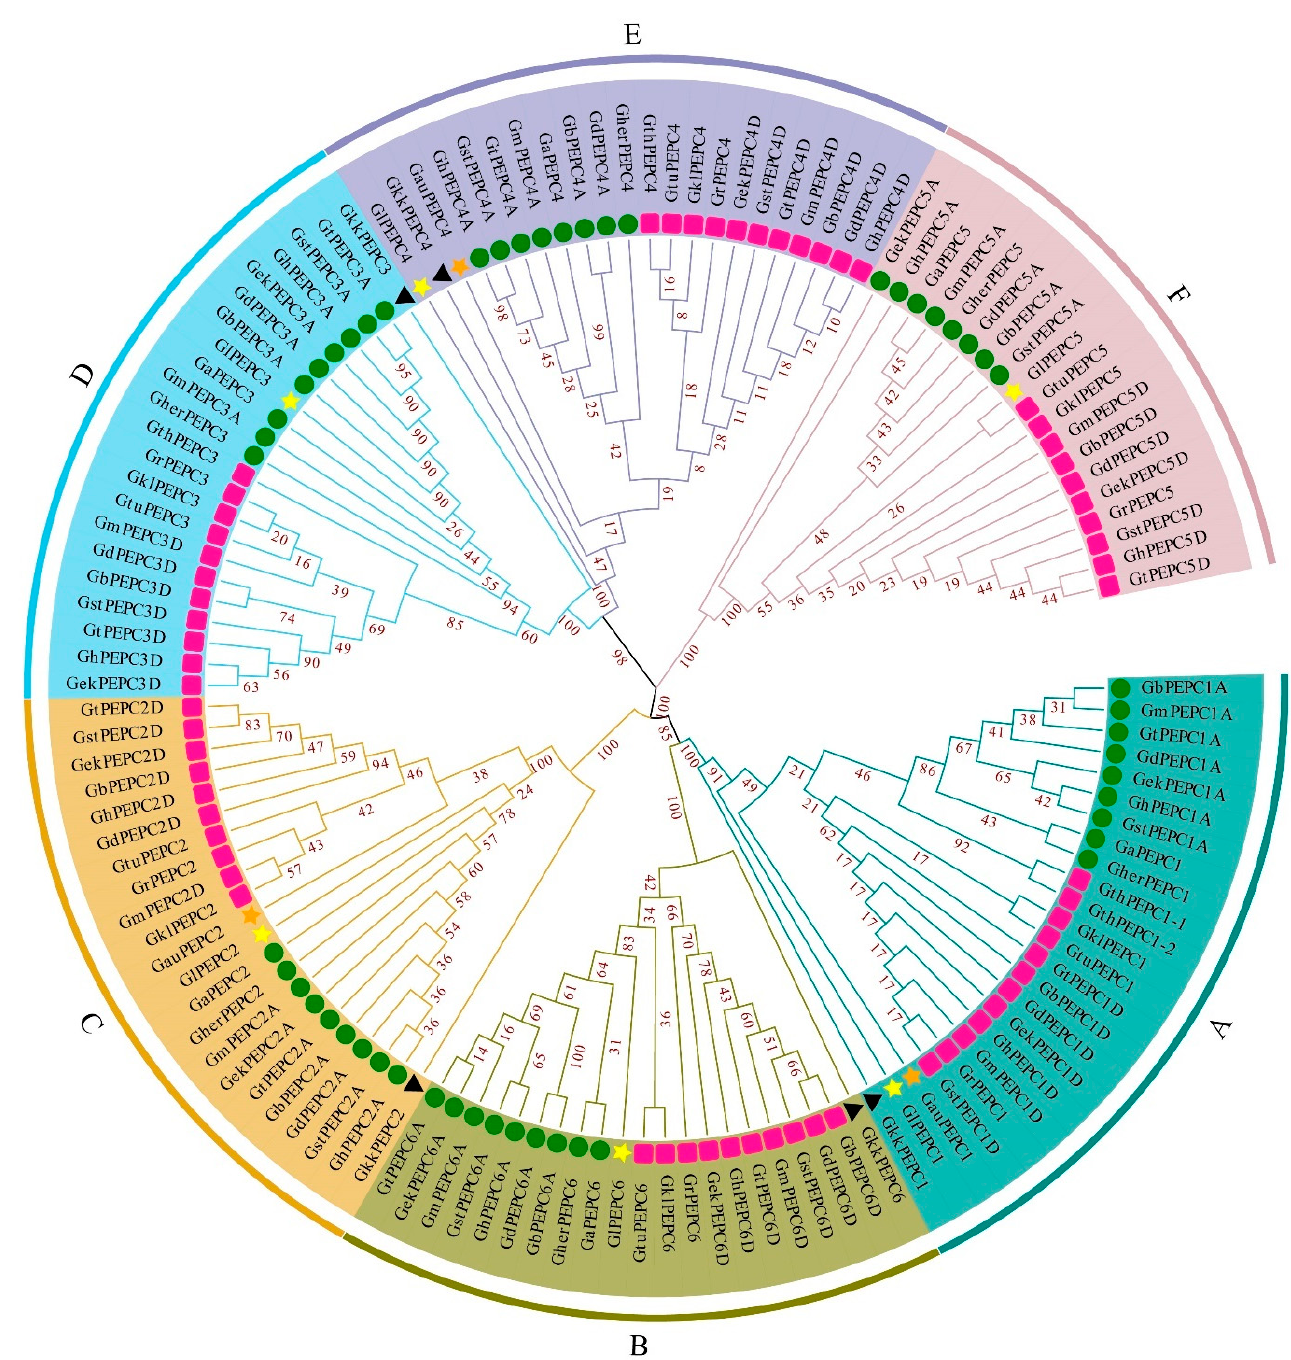
Figure 1. Phylogenetic tree of PEPC proteins from 15 Gossypium species and Gossypioides kirkii . Different colored lines and regions indicate PEPC protein scores in different groups. The green circles and red boxes represent PEPC proteins from A genome and D genome, respectively, black triangles represent PEPC proteins of Gossypioides kirkii , yellow stars represent PEPC proteins of G. longicalyx from F genome and stars represent PEPC proteins of G. australe from G genome. All PEPCs were classified into six groups (A, B, C, D, E and F).